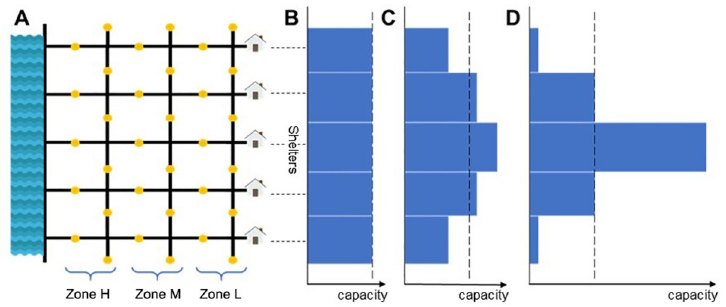
Fig 1. Overview of the model setup. (A) Evacuees are generated at the sources (yellow circles) and head to the nearest shelters at the right (the house shapes) via roads. The left side comprises flood-prone areas. The closer an area to the water, the higher the risk is. Zone H is a high-risk area, and Zone L is a low-risk area. (B-D) Different shelter capacities are set as hard infrastructure properties. The shelter capacity of B is uniform, that of C is moderately nonuniform, and that of D is strongly nonuniform. The dashed lines in B-D indicate the guideline of a uniform capacity.